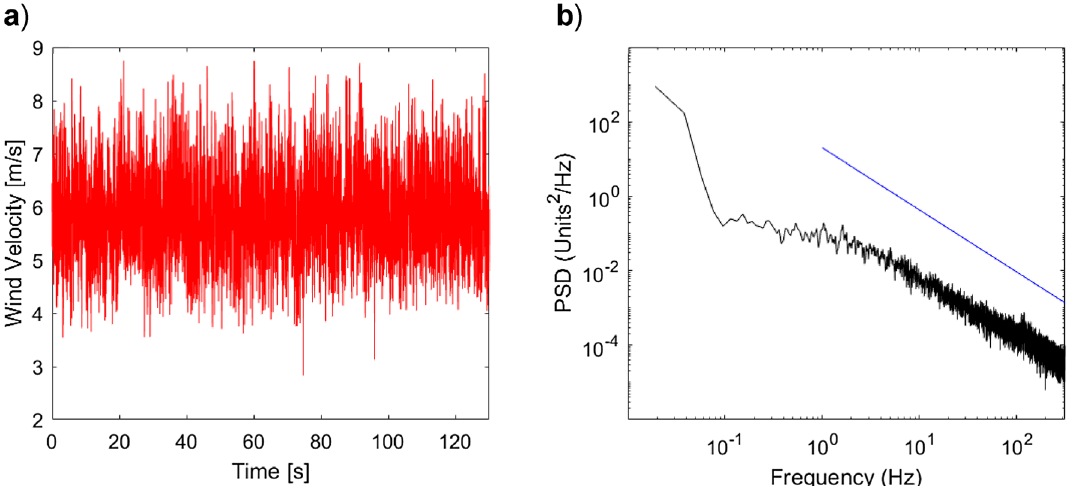
Figure 4. Temporal and spectral characteristics of wind measured in the RMIT Industrial Wind Tunnel configured to facilitate soaring flight. Turbulence grid B is installed, resulting in a turbulence intensity of